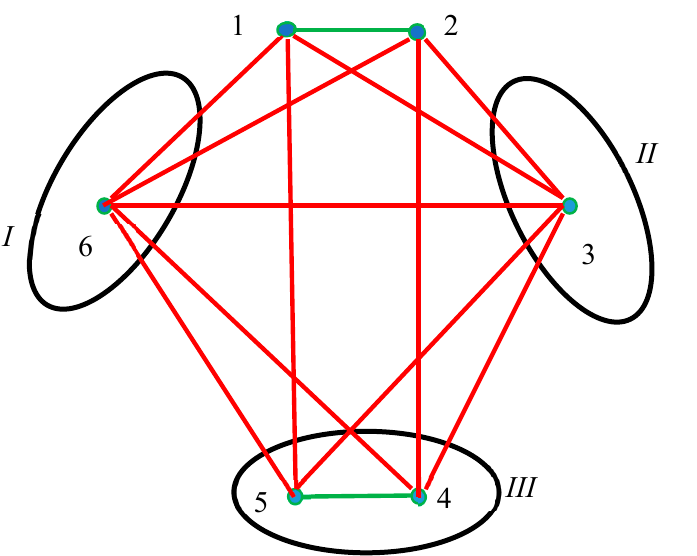
Figure 5. Black solid line depicts three closed Jordan curves dividing the plane into the interior and exterior regions Red edges connect points located in different regions; green edges connect points located in the same region. Triangles “136”, “236”, “346”, “356”, “234” and “156” are monochromatic.